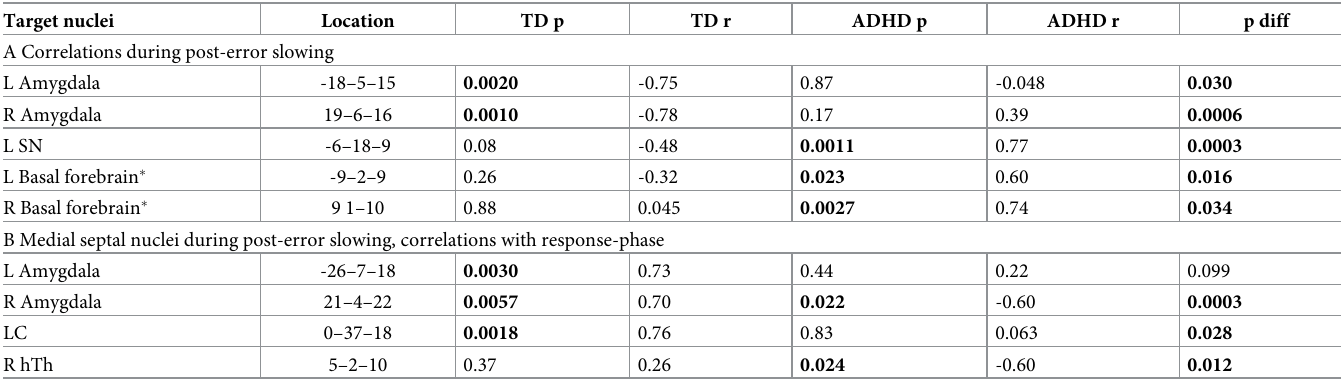
Location (Talairach space), p-values and correlation coefficients (r) for TD and ADHD, and p-values for group difference (TD-ADHD = diff). P-values in bold type passed whole brain correction.